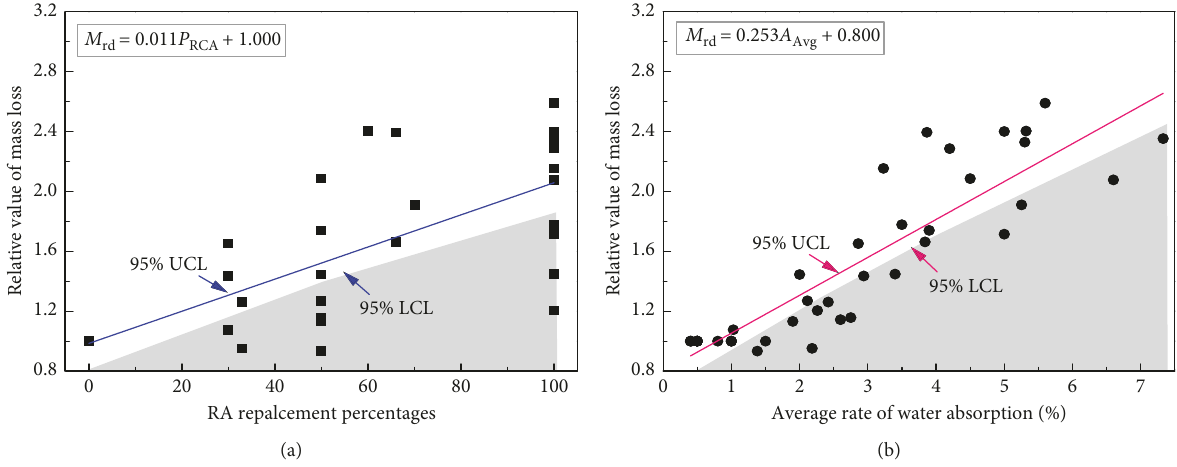
Figure 9: Mass loss of concrete with various contents and average water absorption rate of RA [69, 76, 77, 122–131]. (a) Effects of replacement percentages. (b) Effects of average water absorption rate.